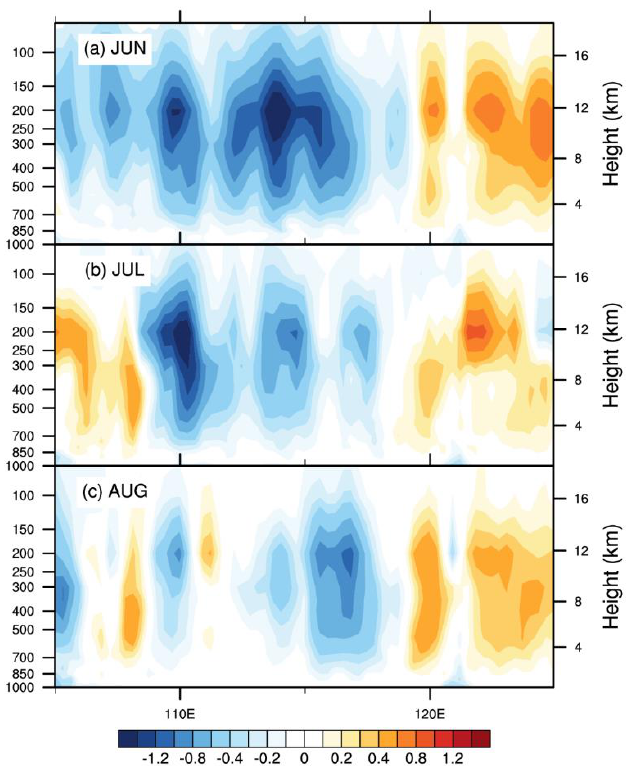
Figure 11. Monthly average difference due to ADE (CTL-SEN test) in the zonal mean vertical velocity (unit: m/s) over SC region on ( a ) June, ( b ) July, and ( c ) August. Left axis stands for pressure levels (unit: hPa) and right axis stands for the height (unit: km).